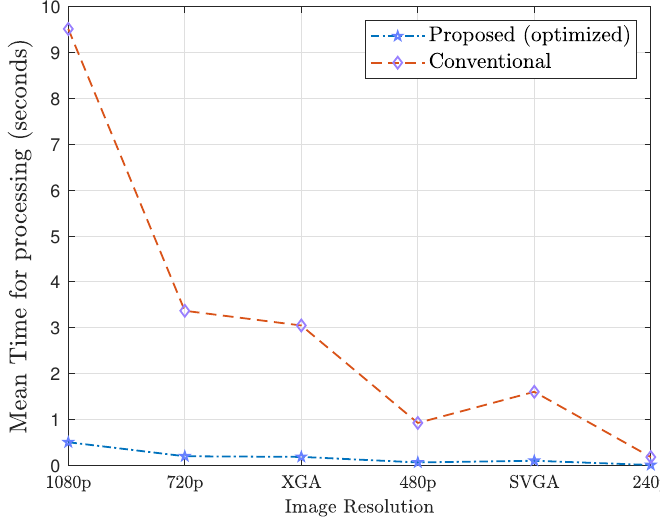
Figure 3. Mean time to process for conventional vs. proposed algorithm for image